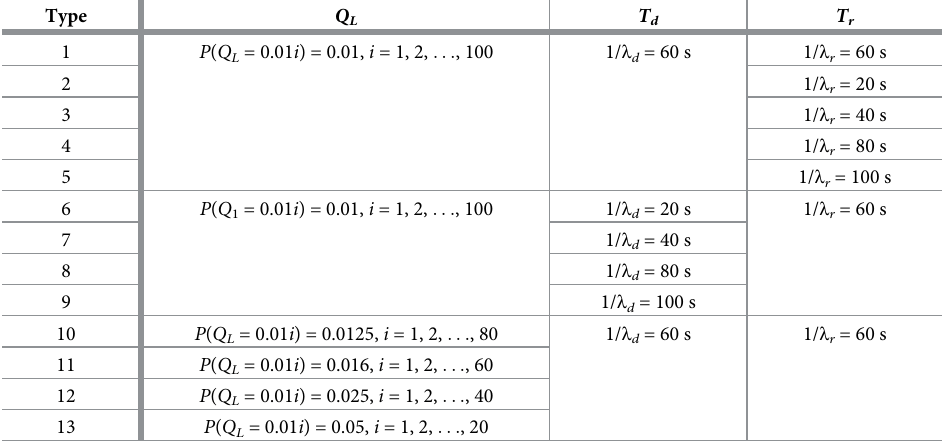
Table 4. Experiments to find how the performance process parameters affect the resilience